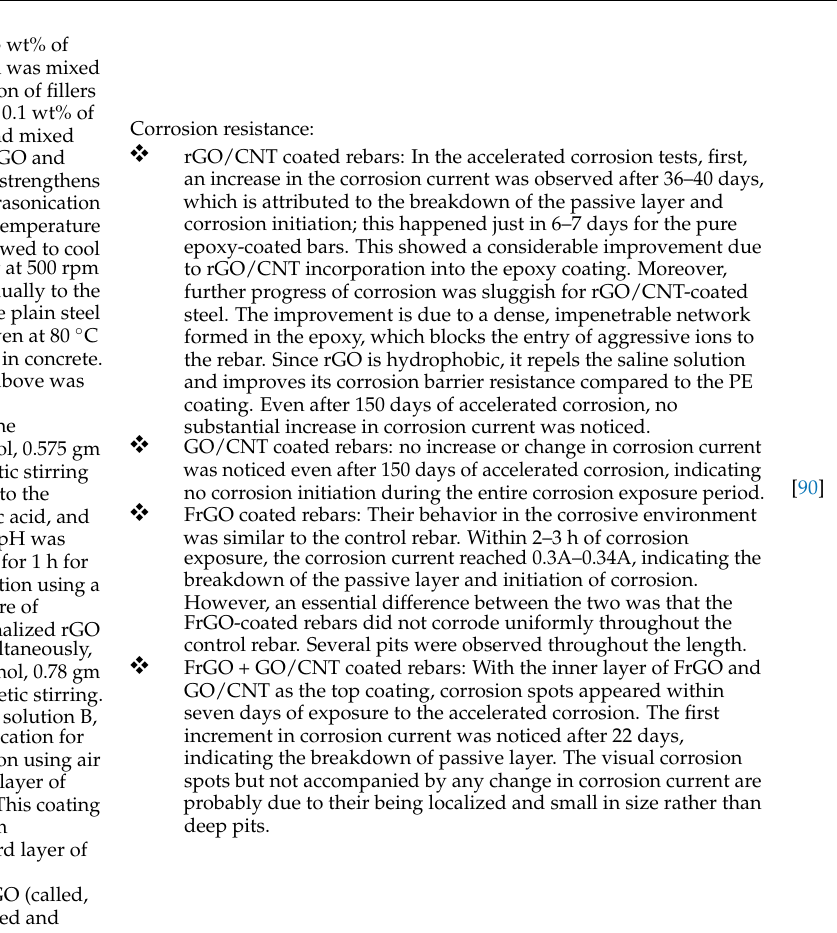
Table 1. Different approaches for improving silane coatings and the main findings, as reported in the literature.